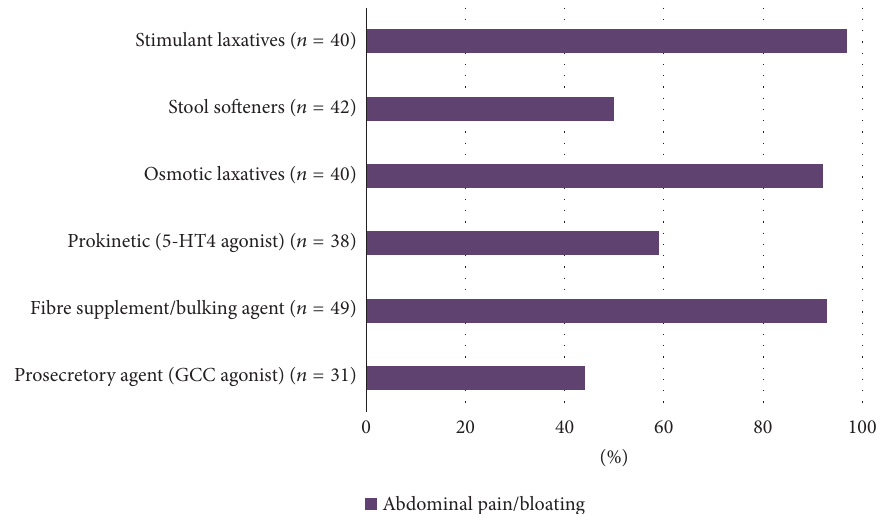
Figure 4: Respondents’ perceptions of symptoms that patients most often complain about while being on various therapy options. For abdominal pain/bloating, which was being identified as the symptom that most affects patients’ quality of life in both CIC and IBS-C, patients who were prescribed GCC agonist appeared to be least likely to report abdominal pain/bloating, suggesting that this agent may be the most effective to alleviate patients with constipation and abdominal pain/bloating. (CIC : chronic idiopathic constipation; IBS-C : constipation- predominant irritable bowel syndrome; GCC : guanylyl cyclase C)